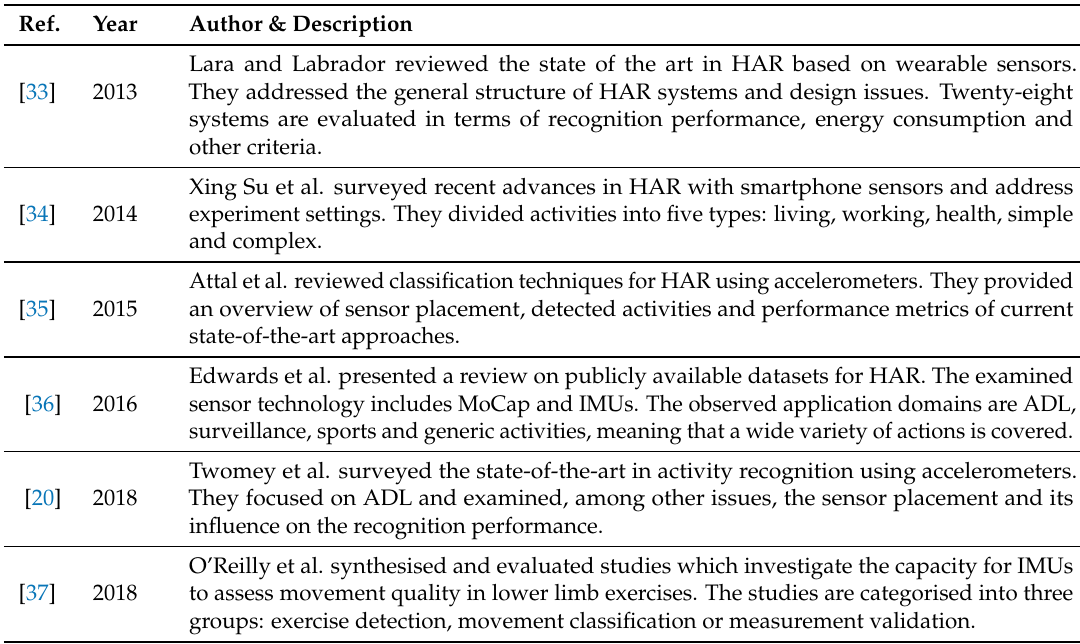
Table 1. Related